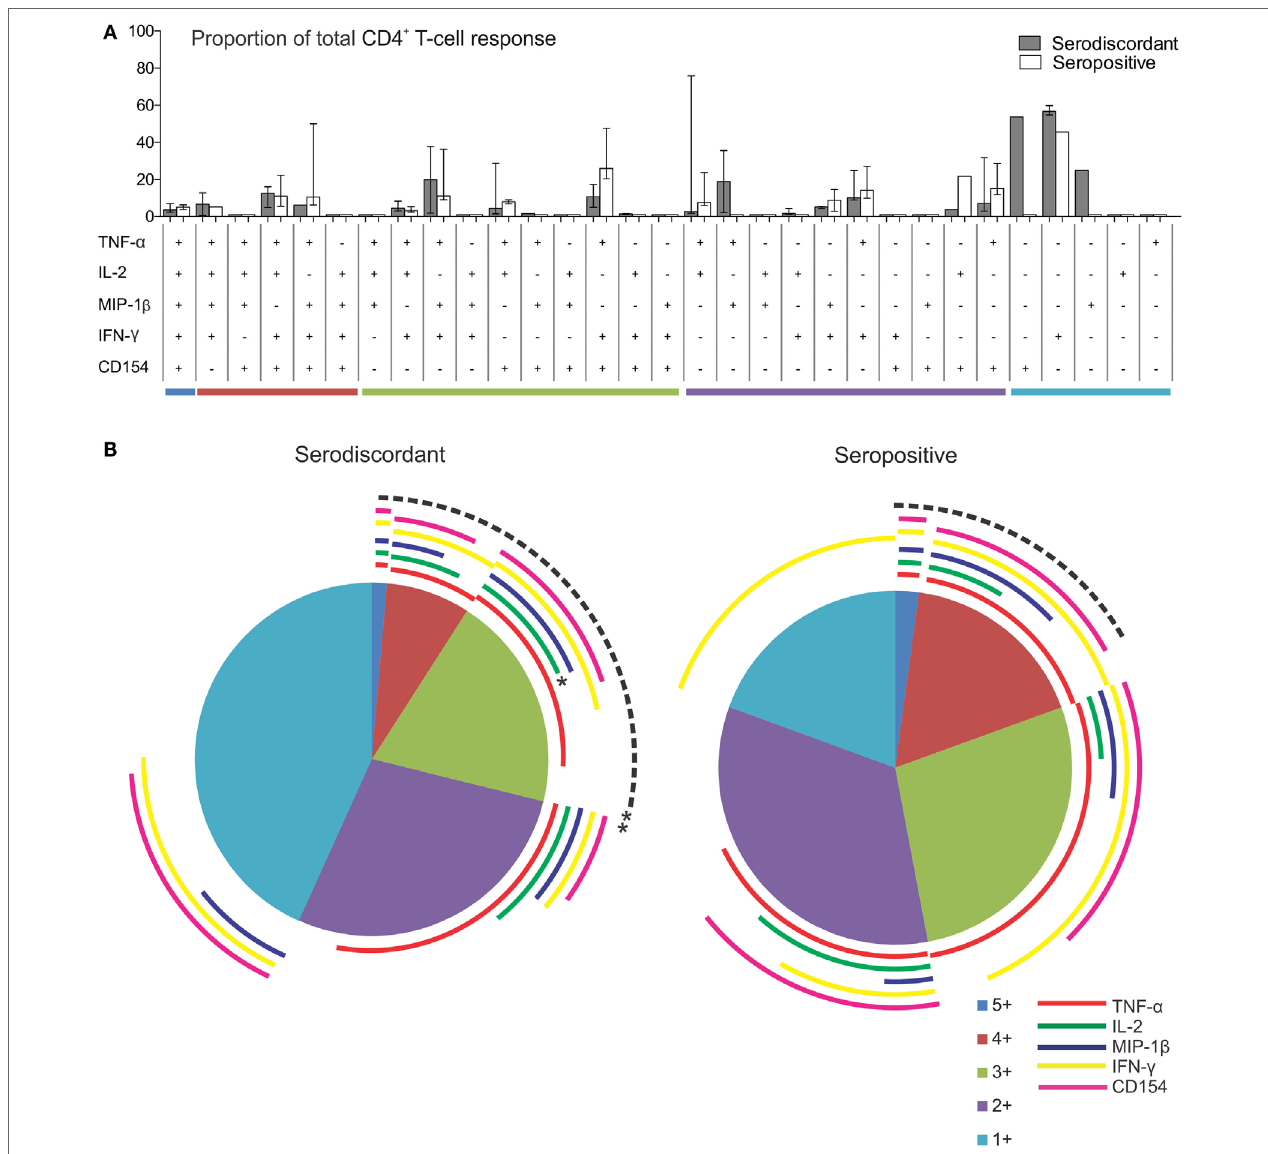
FigUre 3 | Functionality of Trypanosoma cruzi -specific CD4 + T cells in serodiscordant and seropositive subjects for T. cruzi infection. Peripheral blood mononuclear cells (PBMC) were stimulated with a T. cruzi lysate preparation from the Brazil strain and analyzed by flow cytometry for intracellular expression of interferon (IFN)- γ , interleukin (IL)-2, tumor necrosis factor (TNF)- α ; macrophage inflammatory protein (MIP)-1 β and CD154 in CD4 + T-cells. Lymphocytes were gated based on forward scattering (FSC) and side scattering (SSC), and CD3 + cells were then analyzed for CD4 vs. each marker. Cytokine coexpression profiles with one (1 + ), two (2 + ), three (3 + ), four (4 + ), and five (5 + ) functions were determined in serodiscordant and seropositive subjects, using the Boolean gating function of FlowJo software. (a) The contribution of each cytokine-producing subset to the total T. cruzi -specific CD4 T-cell response was assessed in donors with positive responses in the intracellular staining assay as indicated in material and methods (i.e., nine serodiscordant subjects and eight seropositive subjects). Then, the average for each combination was calculated. Bars indicate the percentage of the total response contributed by CD4 + T-cells with a given functional response. Data are represented as median percentages with interquartile range. Responses for all 31 possible subsets are shown for serodiscordant and seropositive subjects. (B) The data are summarized by the pie charts, in which each slice of the pie represents the fraction of the total response that consists of CD4 + T-cells positive for one to five functions (light blue, violet, green, red, and blue, respectively), matched to the horizontal bars in A. The arches indicate the proportion of CD4 + T-cells that express CD154 (pink), IFN- γ (yellow), MIP-1 β (blue), IL-2 (green), or TNF- α (red) in each slice of the pie. ** P = 0.006 compared with the fraction of IL-2 producing cells on the total polyfunctional response in seropositive subjects; * P = 0.02 compared with the fraction of IL-2-producing cells in the slice of the pie with three functions in seropositive subjects, by Student’s t